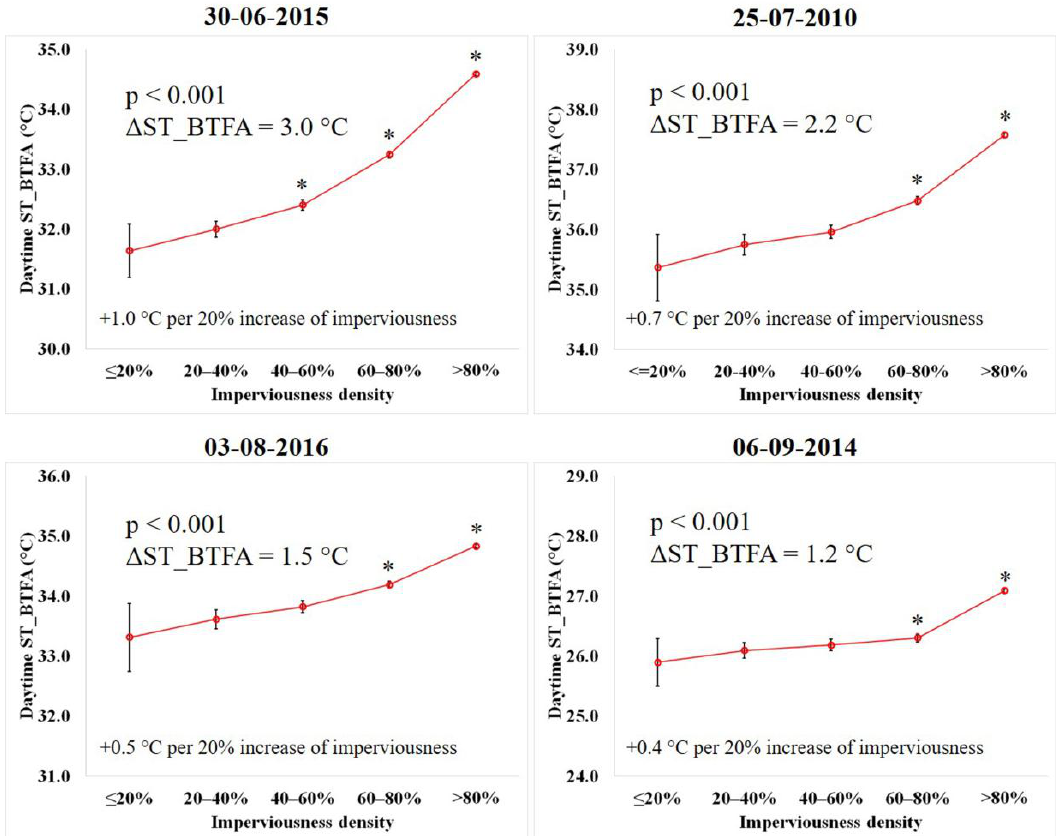
Figure 3. Relationships between daytime mean surface temperatures nearby residential buildings (ST_BTFA) and imperviousness density (ID) groups on four summer days in Parma. ΔST_BTFA represents the difference between the highest and the lowest daytime mean ST_BTFA among ID groups. The 95% confidence intervals for ST_BTFA means are indicated. The p value was assessed by using the Kruskal–Wallis test. * indicates significant daytime ST_BTFA differences ( p < 0.01) compared with all the other ID groups assessed with the Mann–Whitney U test.